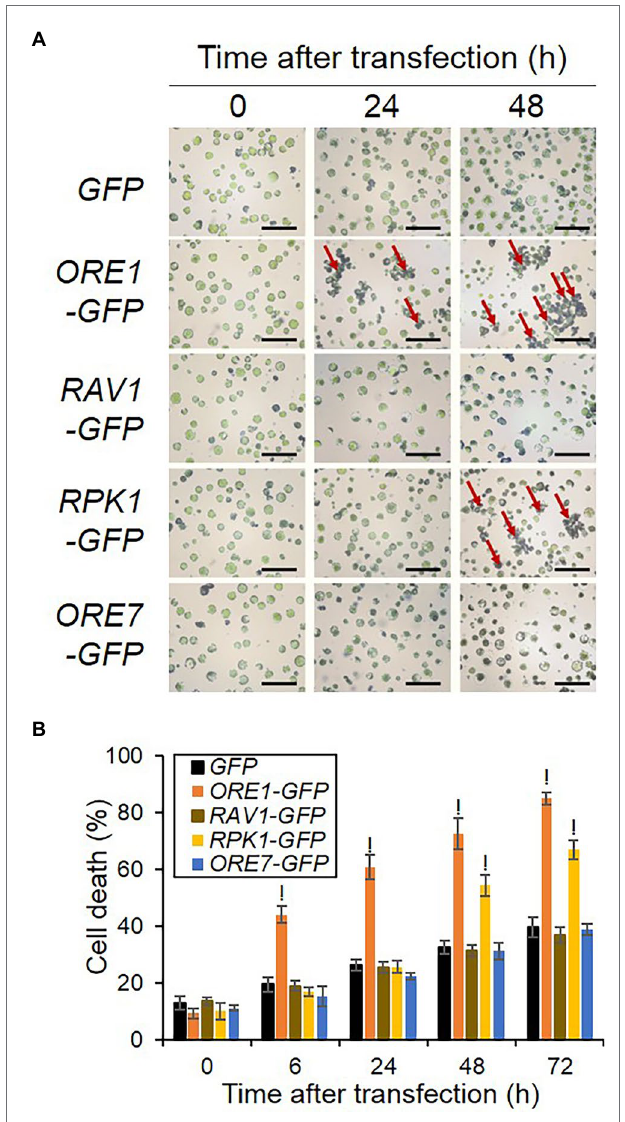
FIGURE 4 | Kinetic cell death responses induced by overexpression of various senescence regulators in Arabidopsis protoplasts. (A) Representative images of protoplasts stained by Evans blue. (B) Time-series measurement of cell death in protoplasts expressing various senescence regulators. Protoplasts were transfected with empty GFP (Control), ORE1-GFP , or RPK1-GFP and stained with Evans blue dye at 0, 6, 24, 48, and 72 h post- transfection. Normal and stained cells were counted in five to 12 fields containing at least 50 cells from each sample under microscopy. The percentage of dead cells was measured as [stained cells/(stained + normal cells)] × 100%. Bars = 1 mm. Data represent mean ± SE ( n = 3). A statistical analysis was performed using a two-tailed Student’s t -test ( ! p < 0.0001). Similar results were obtained in two independent